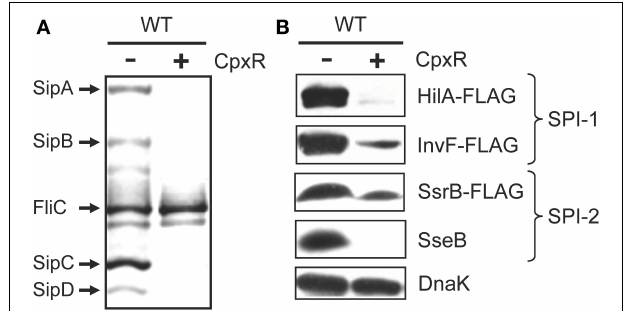
FIGURE 3 | Overexpression of CpxR represses SPI-1 and SPI-2 genes. (A) Secretion analysis of the SPI-1-encoded proteins SipA, SipB, SipC, and SipD was tested in the WT S . Typhimurium strain carrying plasmid pCA-CpxR, grown for 9h in LB medium at 37 ◦ C. FliC is a flagellar protein whose secretion is SPI-1-independent. (B) Expression of the SPI-1-encoded HilA-FLAG and InvF-FLAG and the SPI-2-encoded SsrB-FLAG and SseB, in the WT S . Typhimurium strain carrying the respective chromosomal FLAG-tagged gene and containing plasmid pCA-CpxR, was analyzed by Western blotting using monoclonal anti-FLAG or polyclonal anti-SseB antibodies. Whole cell lysates were prepared from samples of bacterial cultures grown in LB medium at ◦ 37 C for 5 or 9h, for detection of SPI-1- and SPI-2-encoded proteins, respectively. As a loading control, the expression of DnaK was also determined using monoclonal anti-DnaK antibodies. Overexpression ( + ) of CpxR from the T5-lac promoter of plasmid pCA-CpxR was induced by adding 50 µ M IPTG at the beginning of the bacterial